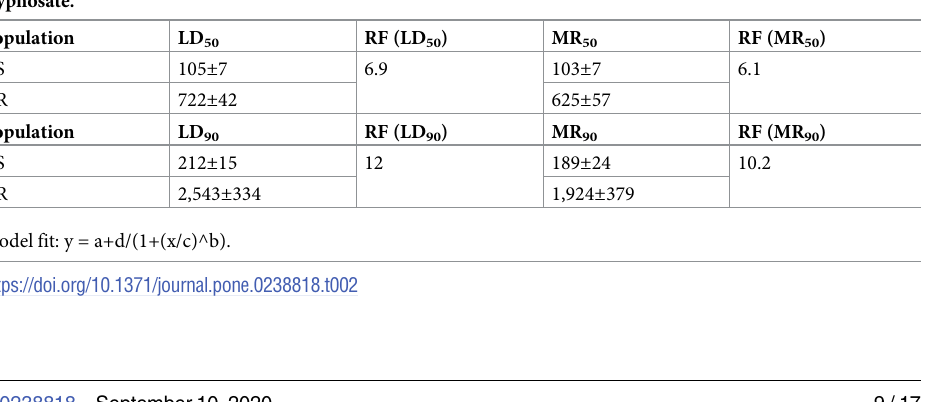
Table 2. Estimated glyphosate doses (g ha -1 ) for 50 and 90% of plant injury (LD) and dry mass reduction (MR), and resistant factors (RF) for wild poinsettia ( Euphorbia heterophylla ) susceptible (GS) and resistant (GR) to glyphosate.